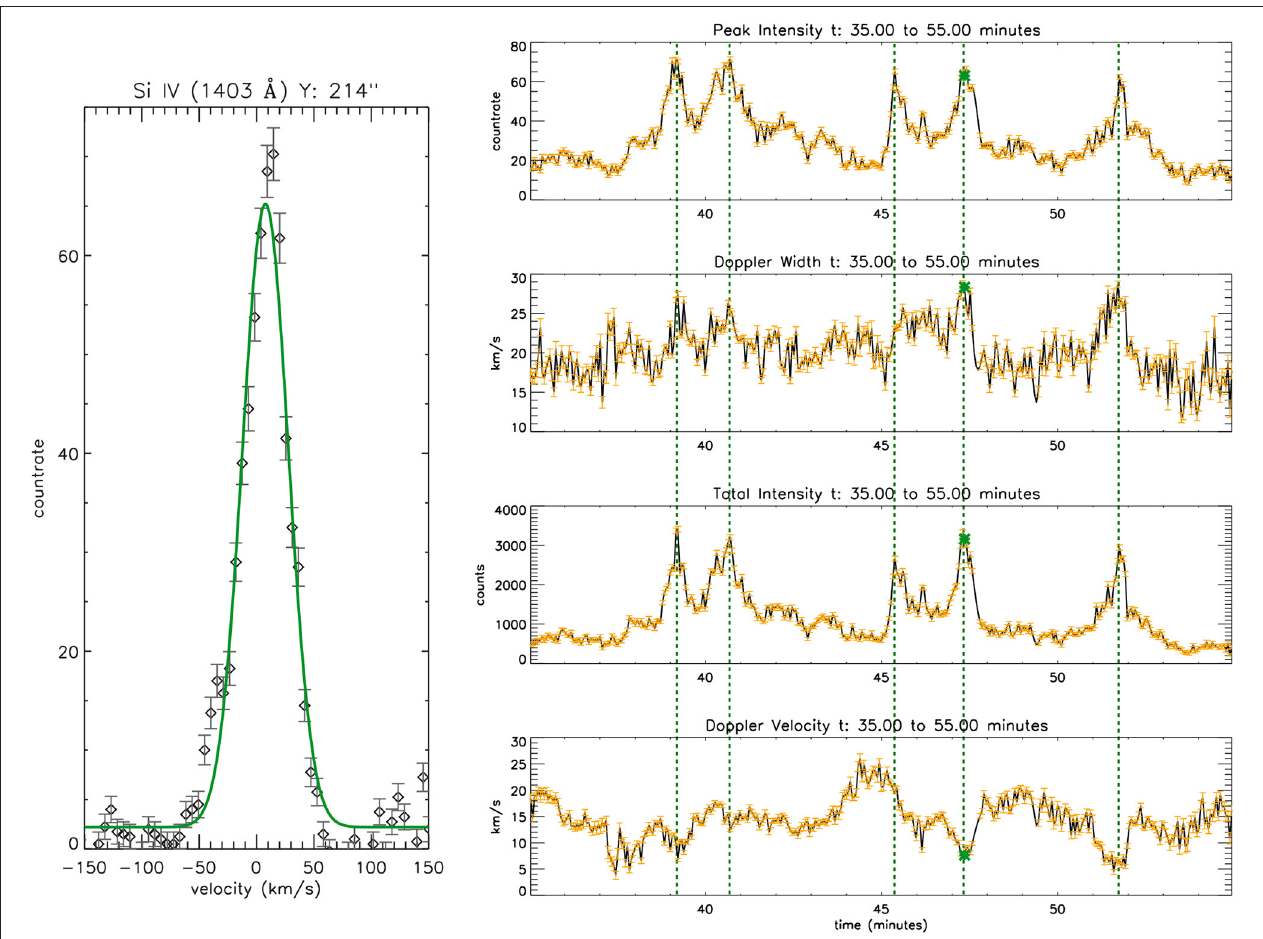
FIGURE 7 | Left panel shows the observed spectral line profile ( black symbols with the observational errors) of SiIV1403Å emission line at location B, with the Gaussian fit ( green solid curve) for a particular instance. Panels on the right show the light-curves (in black ) with the fitting errors (in orange ) of different spectral parameters at B for a duration of 20min. The green solid symbol over the light-curves marks the instant for which the spectral profile is shown in the left panel. The dotted lines shows some instances of the possible reconnection flows. An animation of this figure is available as the supplementary material ( Supplementary Video 1 ) in the online version which shows the evolution of the spectral profile with